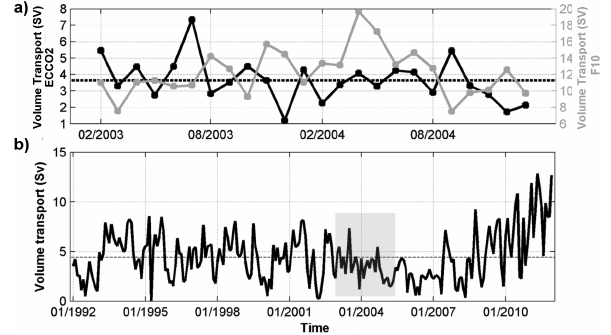
Figure 13. (a) Monthly AABW volume transport (Sv) obtained from the ECCO2 data (black line) and Fukamachi et al. (2010) (gray line) for Section I (see Fig. 1). The averaged ECCO2 reanalysis es- timate is indicated by the black dotted line. (b) Monthly AABW volume transport (Sv) from the ECCO2 data during the entire data period. The gray box highlights the period presented in panel (b) .